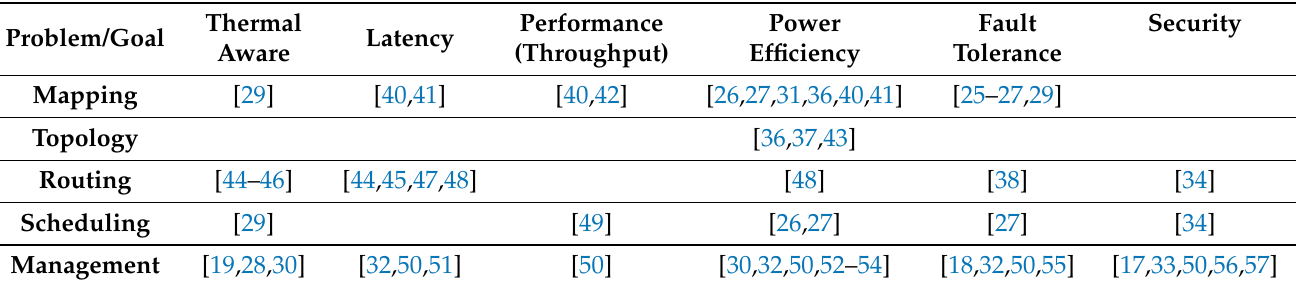
Table 4. Recent literature classification of NoC optimization problems and goals. These works could benefit from an SDNoC architecture. SDNoC will provide a reuse framework for the different solutions proposed in every paper into a single SDNoC